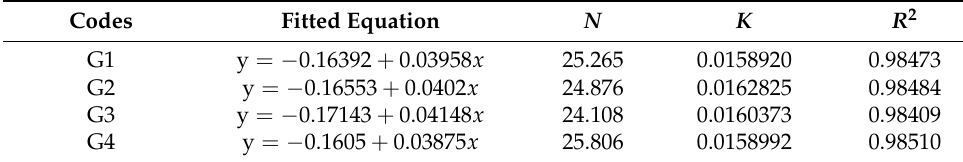
Figure 9. Kondo equation piecewise fitting hydration stable stage (FG stage); ( a ) G1, ( b ) G2, ( c ) G3, ( d ) G4. Table 8. Results of Kondo equation piecewise fitting hydration stable stage.